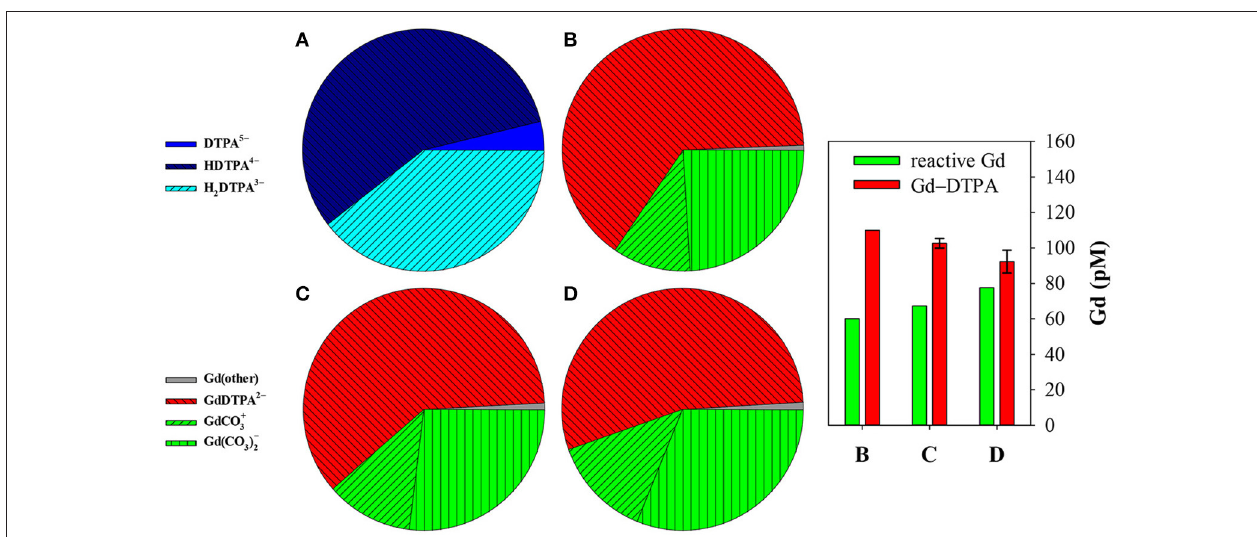
FIGURE 5 | Speciation of Gd and DTPA, calculated with MINEQL, in a seawater sample ( S = 35, pH f = 8.33, T = 25 ◦ C) containing 60 pM “natural” reactive Gd and 110 pM anthropogenic Gd–DTPA, similar to the 2013 San Francisco Bay sample of Hatje et al. (2016). (A) Depicts the distribution of DTPA among its different protonated forms, in the absence of any complexation. Speciation of Gd in (B) does not account for DTPA complexation with Mg and Ca; 100% of DTPA is complexed with Gd. In (C) some Gd–DTPA has dissociated due to the formation of mononuclear Mg–DTPA and Ca–DTPA complexes. Even more dissociates in (D) when dinuclear Mg–DTPA and Ca–DTPA complexes are included. The destabilization of Gd–DTPA is clearly illustrated in the graph on the right, showing relative concentrations of the two Gd fractions; letters on the x-axis correspond to panels on the left. Uncertainties were estimated by re-running MINEQL after modifying all constants with combinations of added/subtracted 2 σ -errors that yield the largest deviations from the model value.